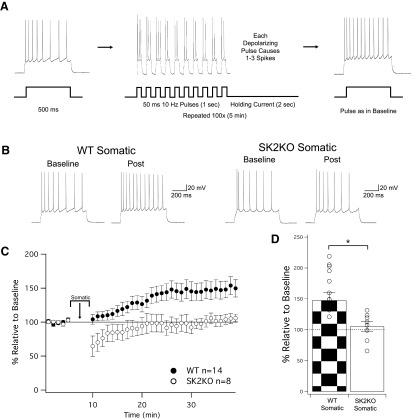
Induction of intrinsic plasticity through somatic depolarization is SK2 dependent. A, Protocol for inducing changes in intrinsic plasticity, modeled off of Mahon and Charpier (2012). As before, a test pulse of 500 ms is repeated at 0.05 Hz in order to induce four to eight spikes. Following a 5-min baseline, the induction protocol injects depolarizing current at 10 Hz (50-ms pulses), evoking one to three spikes per pulse for 1 s, followed by 2 s of holding current. This 3-s sequence is repeated 100 times for a total of 5 min, and then test pulses identical to baseline are again delivered to monitor for changes in excitability. B, Example traces of WT neurons and SK2KO neurons before and after the induction protocol. C, Time graph for changes in spiking relative to baseline, induction protocol occurs from minute 5 to 10. D, Bar graph for change in spiking relative to baseline. WT significantly increased from baseline, while SK2KO did not (p = 0.0028 and p = 0.55, respectively). The increase observed in WT cells was significantly greater than the changes observed in the SK2KO group (p = 0.044). *p < 0.05.